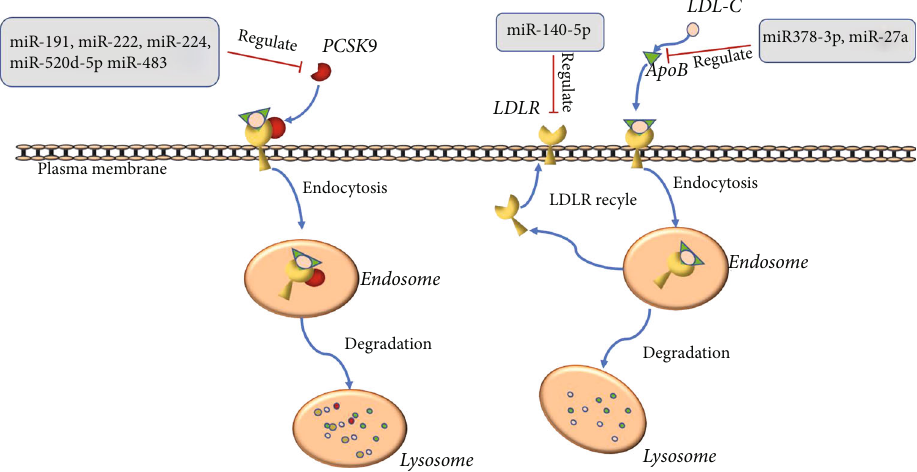
Figure 2: A schematic view of miR-mediated regulation of hyperlipidemia. Table 1: The relationship between miRNAs, targets, and